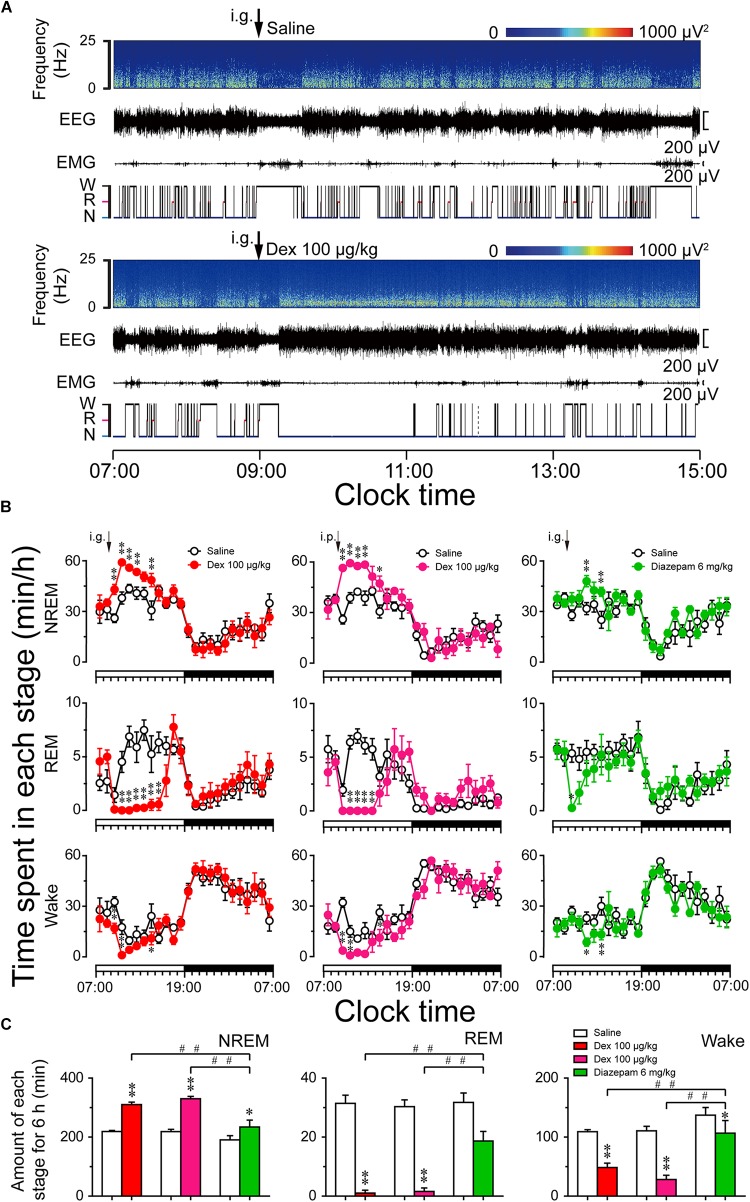
Sleep–wake profiles produced by administration of dexmedetomidine in mice during the light phase. (A) Typical examples of compressed spectral array (0–25 Hz) EEG, EMG, and hypnograms over 8 h (07:00–15:00) following saline (upper panel) and dexmedetomidine 100 μg/kg (lower panel) administration. (B) Time course changes in NREM sleep, REM sleep, and wakefulness following saline (open circle), dexmedetomidine i.g. (100 μg/kg; closed red circle), dexmedetomidine i.p. (100 μg/kg; closed rose red circle), and diazepam i.g. (6 mg/kg; closed green circle) administration during the light phase. The horizontal open and filled bars on the X-axes indicate the 12-h light and 12-h dark periods, respectively. Each circle represents the hourly mean ± SEM of NREM sleep, REM sleep, and wakefulness (n = 6). ∗P < 0.05 and ∗∗P < 0.01 indicate significant differences compared with their own control as assessed by two-way repeated measures ANOVA followed by Bonferroni tests. (C) Total time spent in NREM sleep, REM sleep, and wakefulness for 6 h after administration. Open, red, rose red, and green filled bars show the profiles of saline, dexmedetomidine (i.g. or i.p.), and diazepam i.g. treatments, respectively. Values are mean ± SEM (n = 6). ∗P < 0.05 and ∗∗P < 0.01 indicate significant differences compared with their own control as assessed by two-tailed paired Student’s t-test. ##P < 0.01 indicate significant differences compared dexmedetomidine i.g. with dexmedetomidine i.p. and diazepam i.g. as assessed by one-way ANOVA followed by Bonferroni tests.